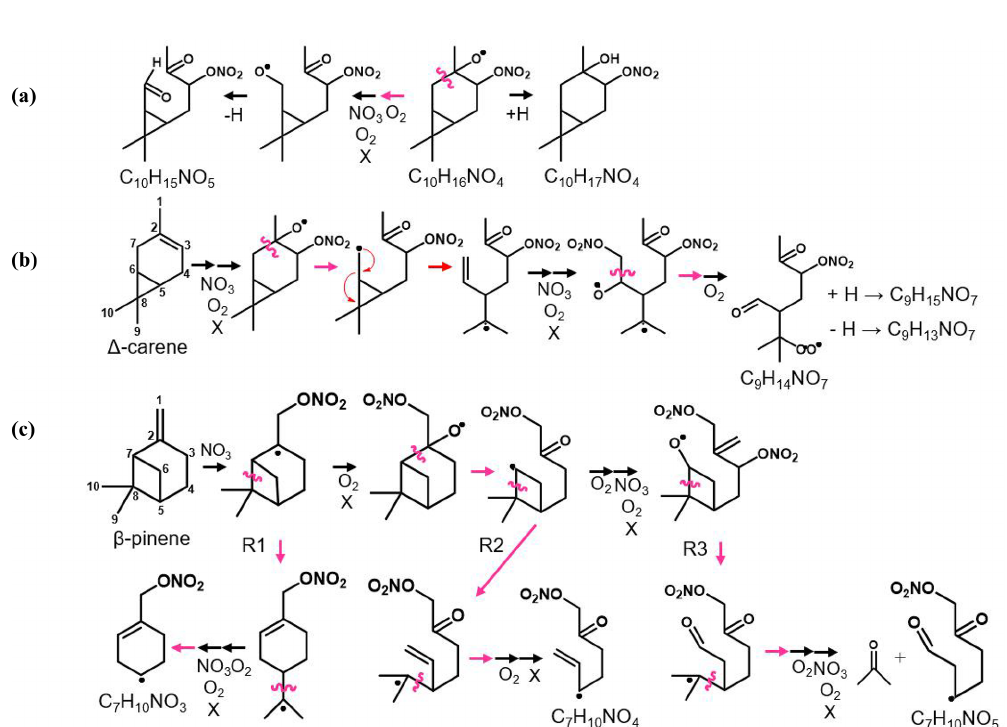
Figure 5. Scheme of the mechanistic pathways listed in Table 1. Potential bimolecular reaction partners in a nighttime atmosphere (NO 3 , RO 2 , and HO 2 ) are abbreviated as “X”. Panel (a) shows (cid:49) -3-carene oxidation as an example of how the hydrogen number can indicate radical termination. Panel (b) shows a C 9 fragment formation pathway available to the (cid:49) -3-carene and α -thujene systems. Panel (c) shows two potential C 7 fragment formation pathways available to the β -pinene and α -pinene